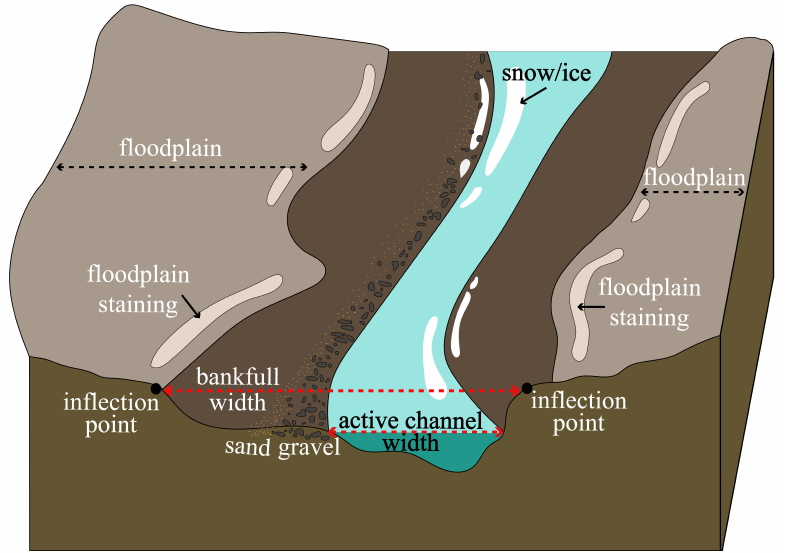
Figure 1. Cross section of stream indicators differentiating bankfull width and active channel width which are indicated by the red dotted arrows at the cross